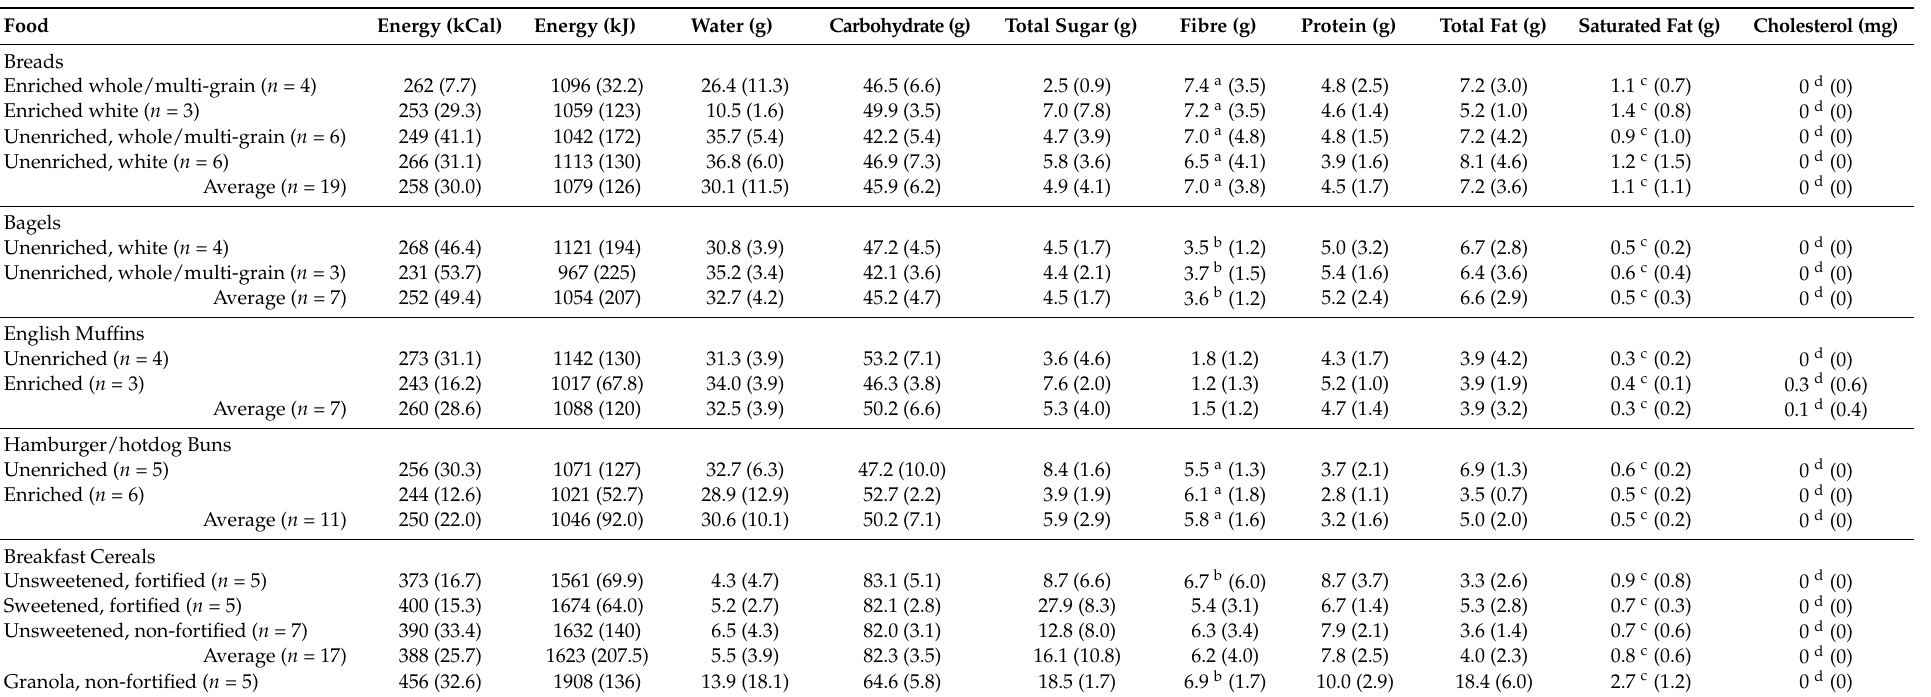
Table 1. Energy and macronutrient content of gluten-free bread and cereal products per 100 g